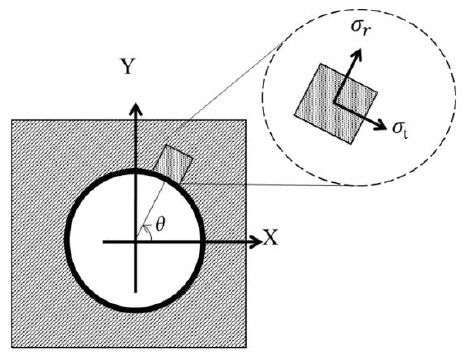
Figure 1. Definition of laminate stresses .